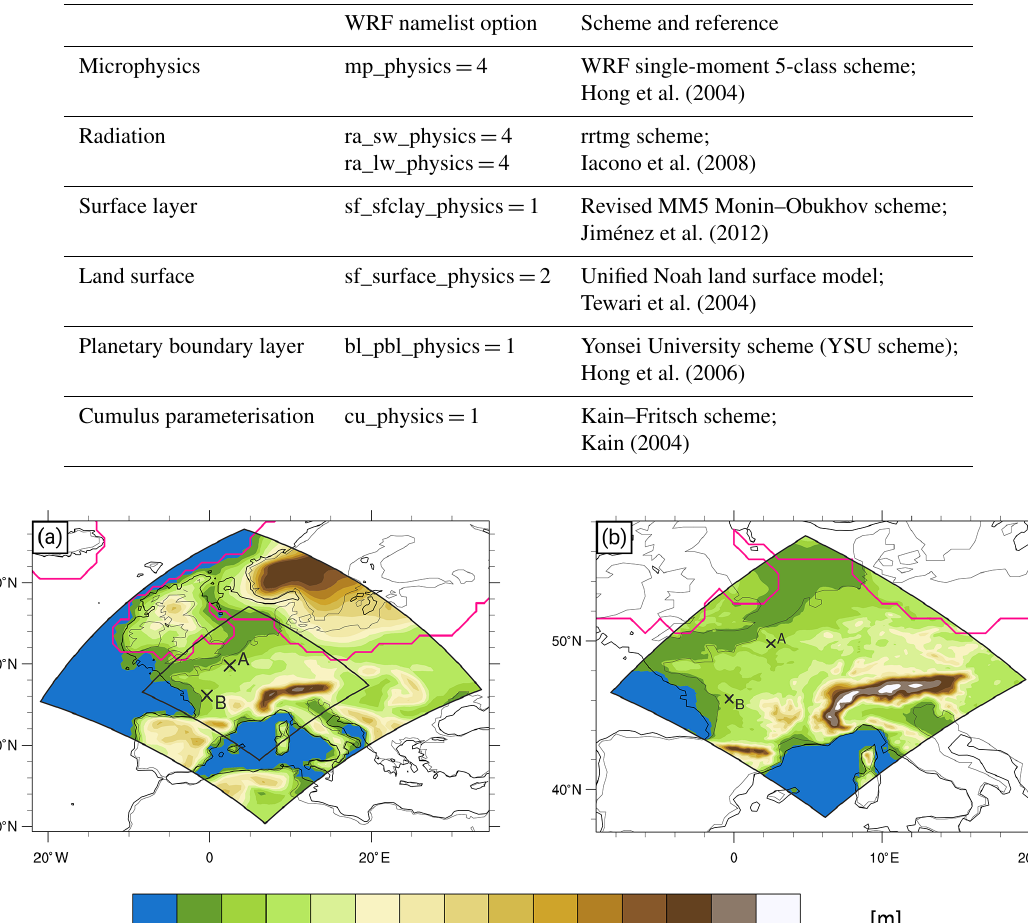
Table 1. Physical parameterisation schemes used for the regional simulations.